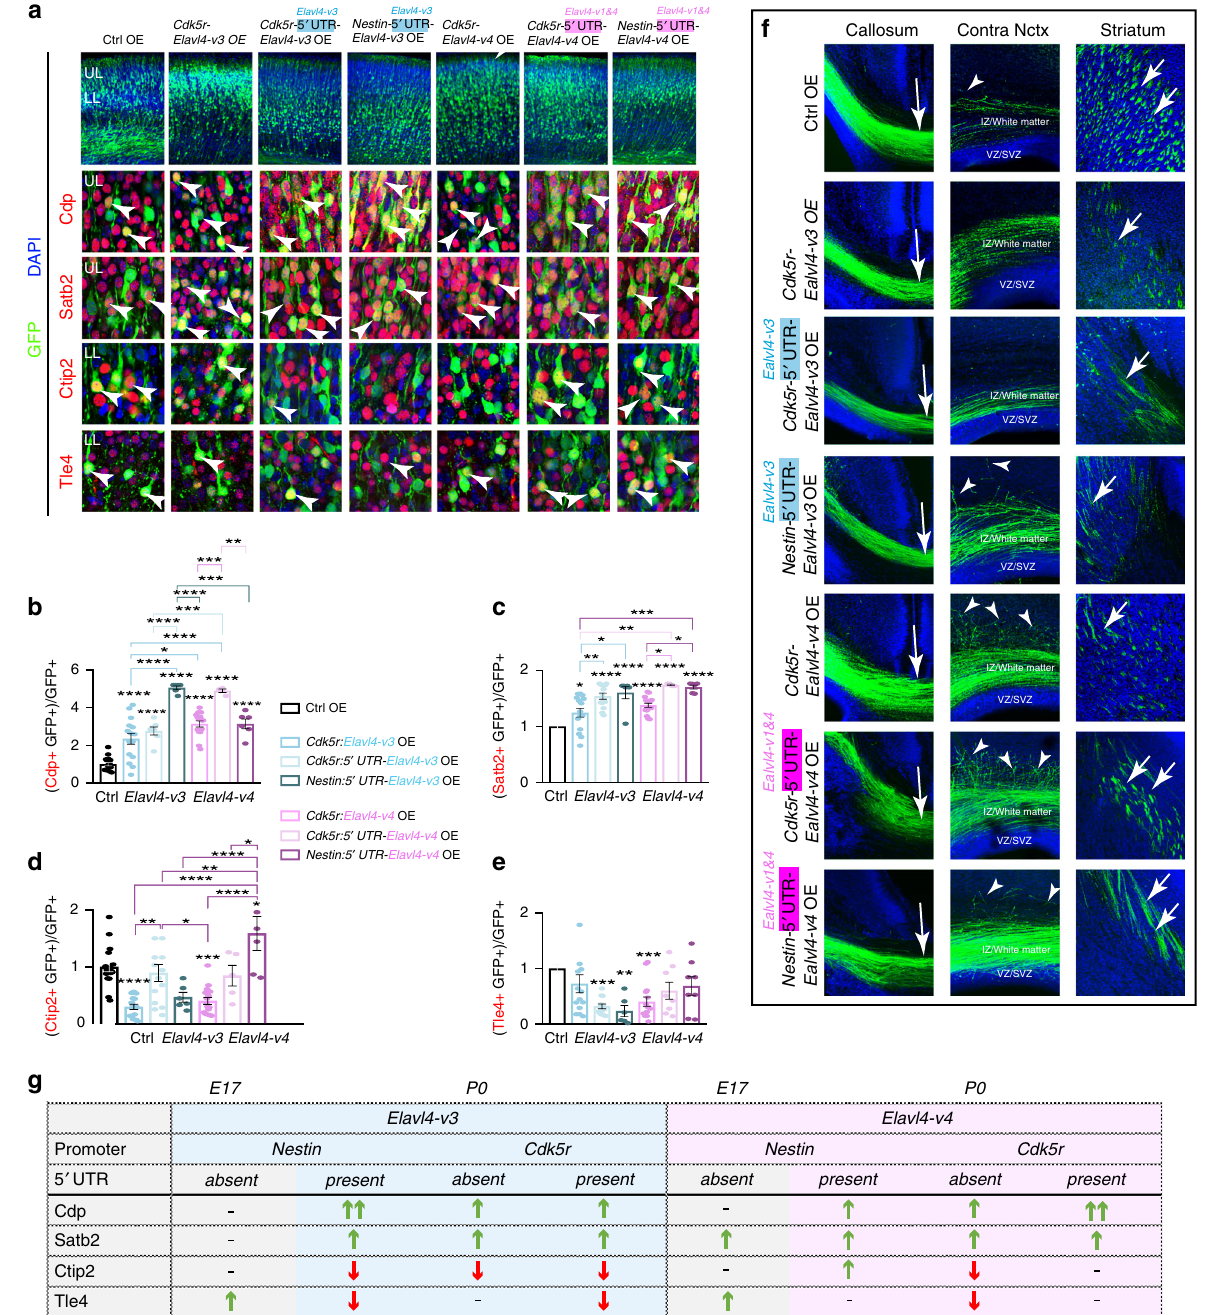
Fig. 7 Native 5 ′ UTRs of Elavl4 isoforms dictate neocortical glutamatergic identities. a (top) P0 representative confocal images of E13 IUE neocortices electroporated with CAG-GFP and either Ctrl ( n = 6 animals), Cdk5r:Elavl4-v3 ( n = 5 animals), Cdk5r:5 ′ UTR-Elavl4-v3 ( n = 4 animals), Nestin:5 ′ UTR-Elavl4- v3 ( n = 3 animals), Cdk5r:Elavl4-v4 ( n = 6 animals), Cdk5r:5 ′ UTR-Elavl4-v4 ( n = 3 animals), Nestin:5 ′ UTR-Elavl4-v4 ( n = 3 animals) OE plasmids. IHC for GFP (green), and cortical layer identity markers Cdp, Satb2, Ctip2, or Tle4 (all red). Scale bar: 20 μ m. DAPI shown in blue. b – e Quanti fi cation of colocalization between layer markers (arrowheads in A) and GFP normalized to controls. Data represent the mean of sections and SEM. Statistics: one-way ANOVA with a post-hoc Tukey ʼ s. * p < 0.05, ** p < 0.01, *** p < 0.001, **** p < 0.0001. All signi fi cance stars that are located directly above bars are in reference to the Ctrl, otherwise indicated with line above. f P0 representative confocal images of E13 IUE neocortices electroporated with GFP and either Ctrl ( n = 6 animals), Cdk5r:Elavl4-v3 ( n = 5 animals), Cdk5r:5 ′ UTR-Elavl4-v3 ( n = 4 animals), Nestin:5 ′ UTR-Elavl4-v3 ( n = 3 animals), Cdk5r:Elavl4-v4 ( n = 6 animals), Cdk5r:5 ′ UTR-Elavl4-v4 ( n = 3 animals), Nestin:5 ′ UTR-Elavl4-v4 ( n = 3 animals) OE plasmids IHC for GFP (green). Arrows indicate GFP + axons passing through corpus callosum and striatum ipsilateral to IUE site. Arrowheads indicate GFP + axons growing into neocortex contralateral to IUE site. DAPI shown in blue. Scale bar: 200 μ m. g Summary table of results in Fig. 6 (E17; gray) and 7a-7e (P0; colored). Increased colocalization is indicated with a green up arrow and decreased colocalization is indicated with a red down